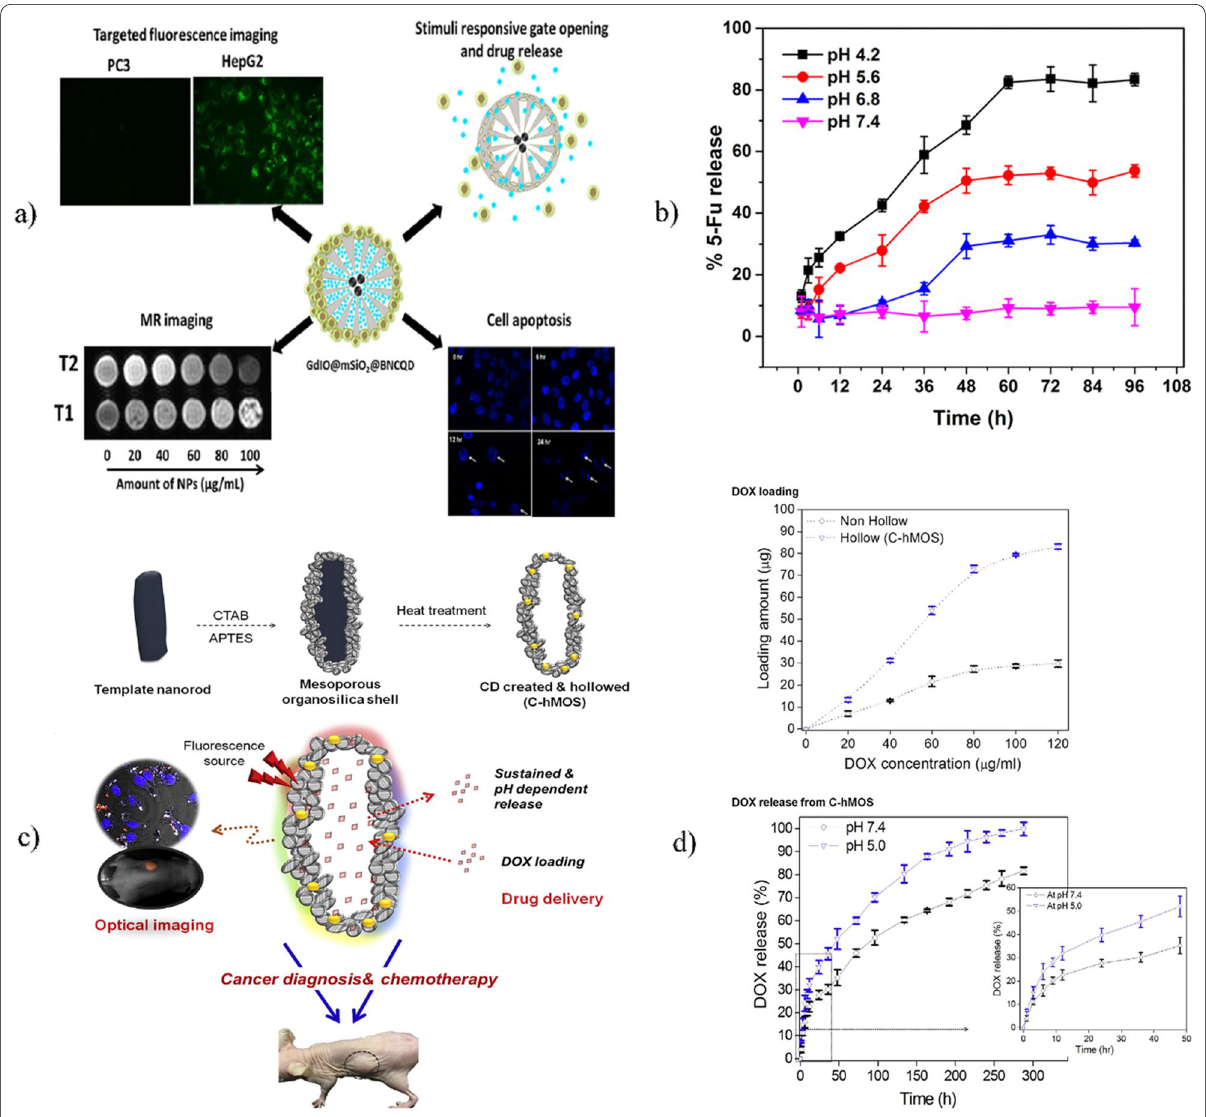
Fig. 4 Schematic representation of multifunctional nanoplatform construction for theragnostic applications. a Hybrid nanoplatform composed of a core of magnetic gadolinium oxide nanoparticles coated with silica and charged with 5‑fluorouracil and carbon quantum dots functionalized with boronic acid as a lid. b Graph of drug release at different pH values. Adapted with permission from ref. [230] © Copyright 2018 Elsevier. c CD/hollow nanoparticles used for drug delivery and bioimaging. d Graph of drug loading and pH‑dependent release [151] © Elsevier